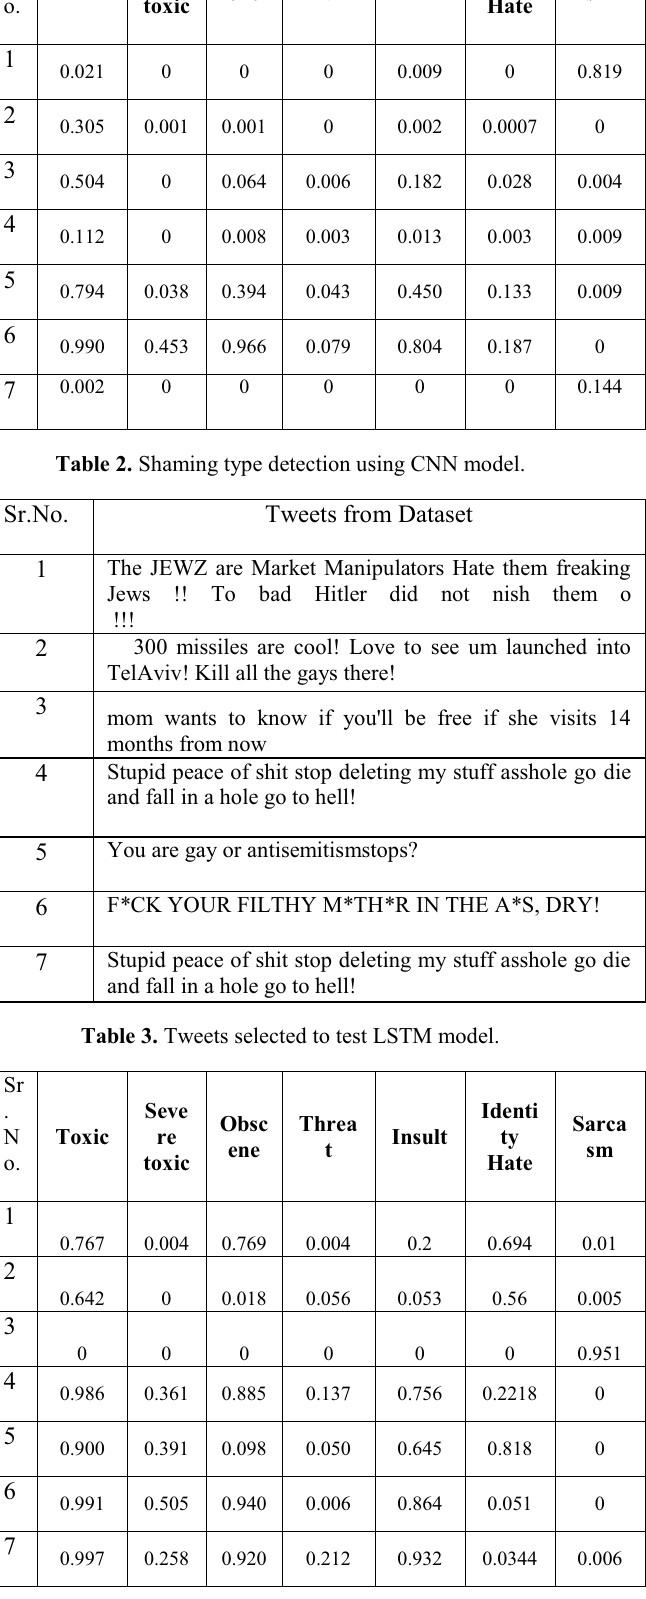
Table 4. Shaming type detection using LSTM